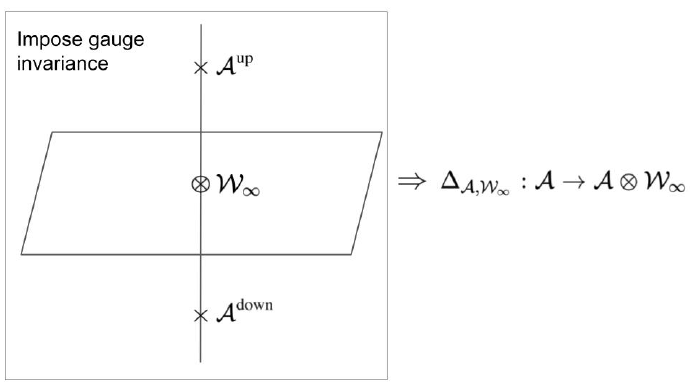
Figure 2: Imposing the gauge-invariance of the coupled system of the line defect and the surface defect induces the coproduct ∆ t , t (cid:48) , ˜ t are elements of A , A 2,0 2,0 2,0